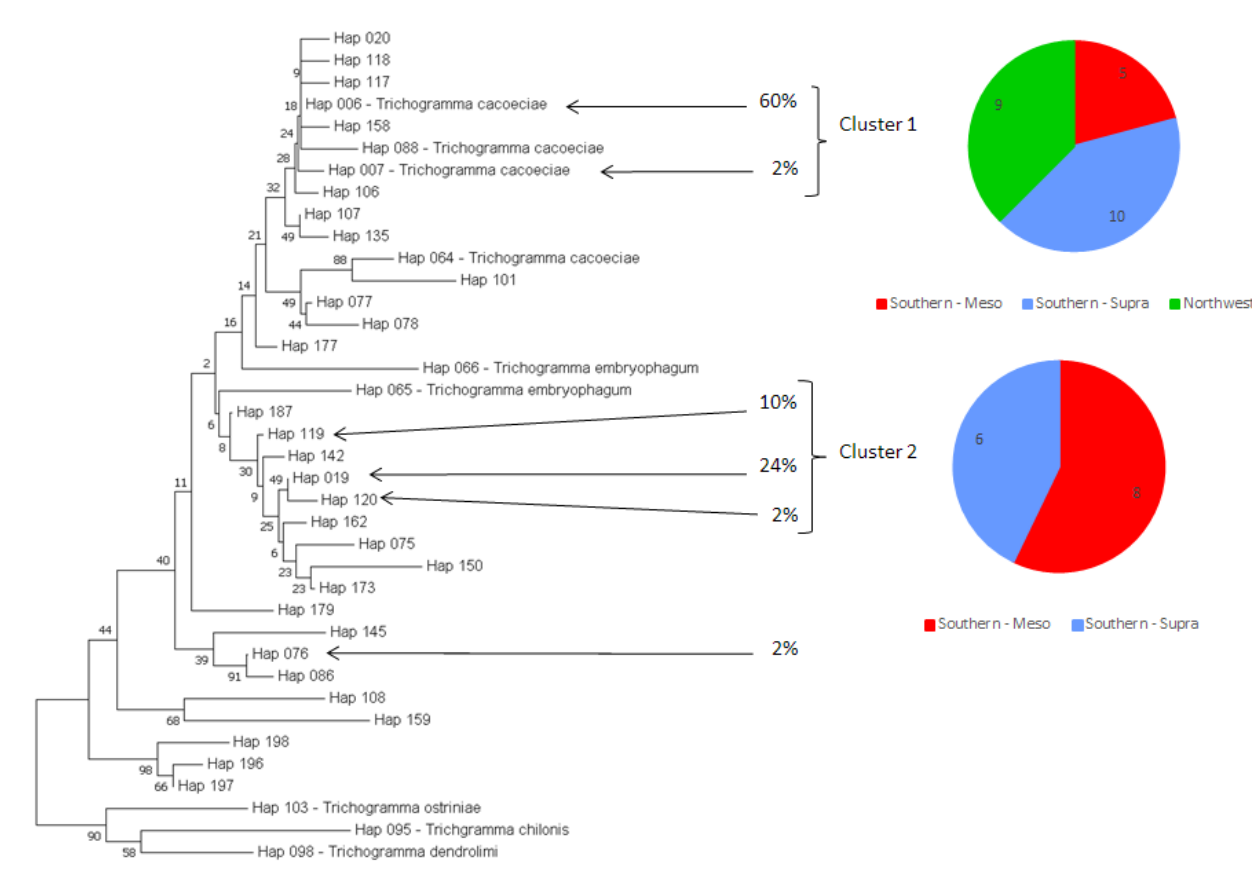
Figure 2. Neighbor-joining tree obtained using part of the mitochondrial gene COI. The evolutionary distances were computed using the Kimura 2-parameter method using 500 replicates for bootstrap tests. The final set included a total of 272 positions, all ambiguous positions having been previously removed for each sequence pair. Percentages indicate the frequencies of the haplotypes within the strains used in this study.